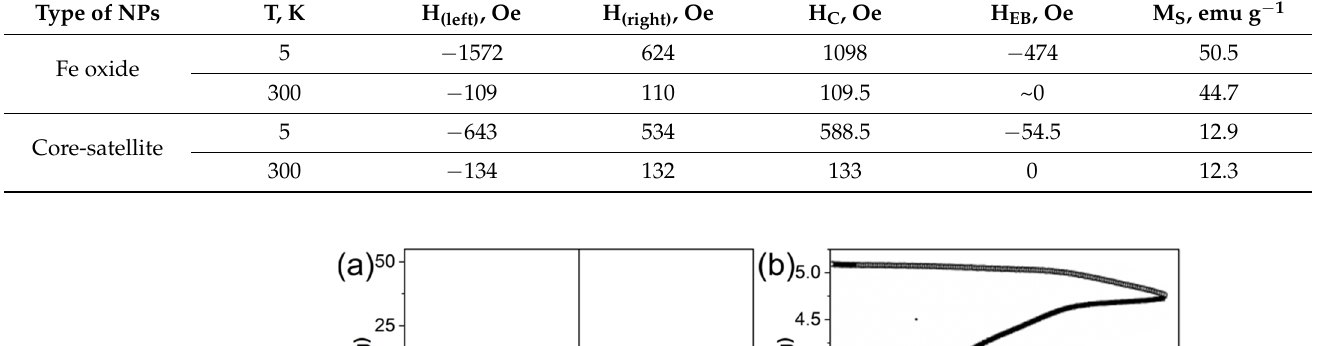
Table 1. Magnetization values of Fe oxide NPs and core-satellite Au-Fe NPs at 5 K and 300 K. M S — magnetization saturation, H (left) —intersections on the field axis at increasing and decreasing fields (H (right) ), H C —coercive field, H EB —exchange bias field. Type of NPs T, K H (left) , Oe